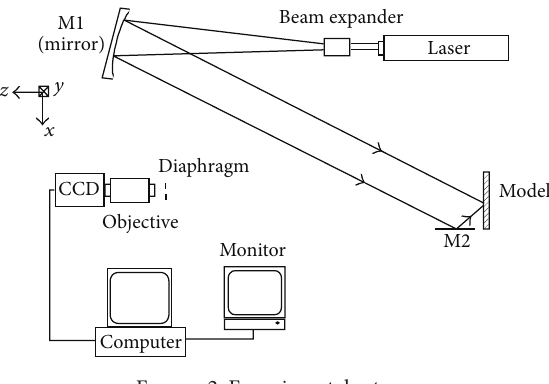
Figure 2: Experimental set-up.